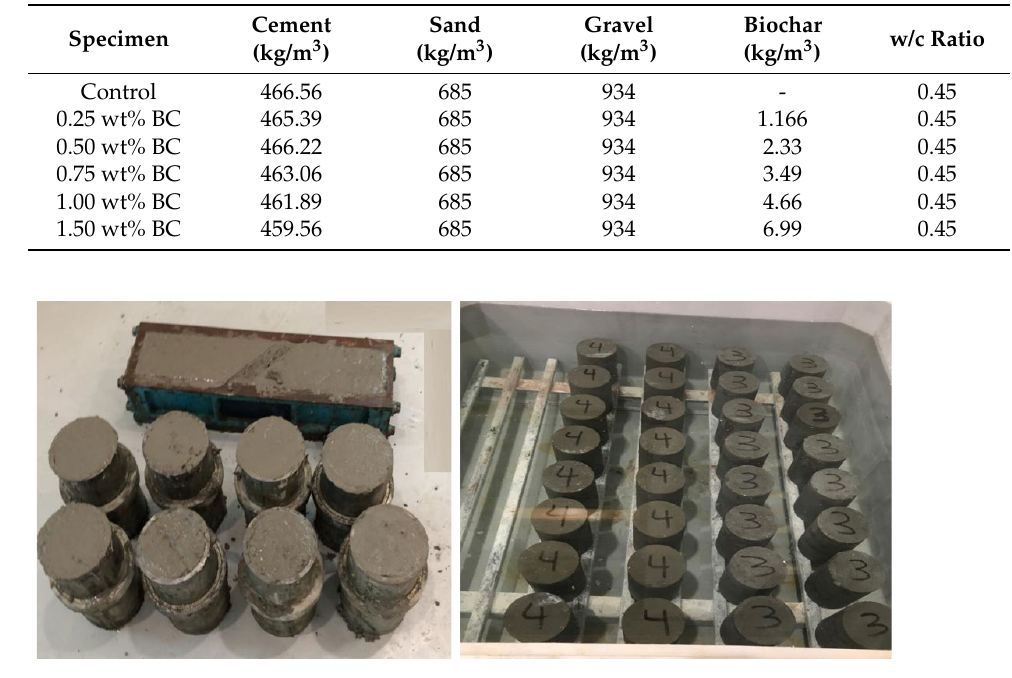
Figure 1. Concrete cylinder and beam specimens.